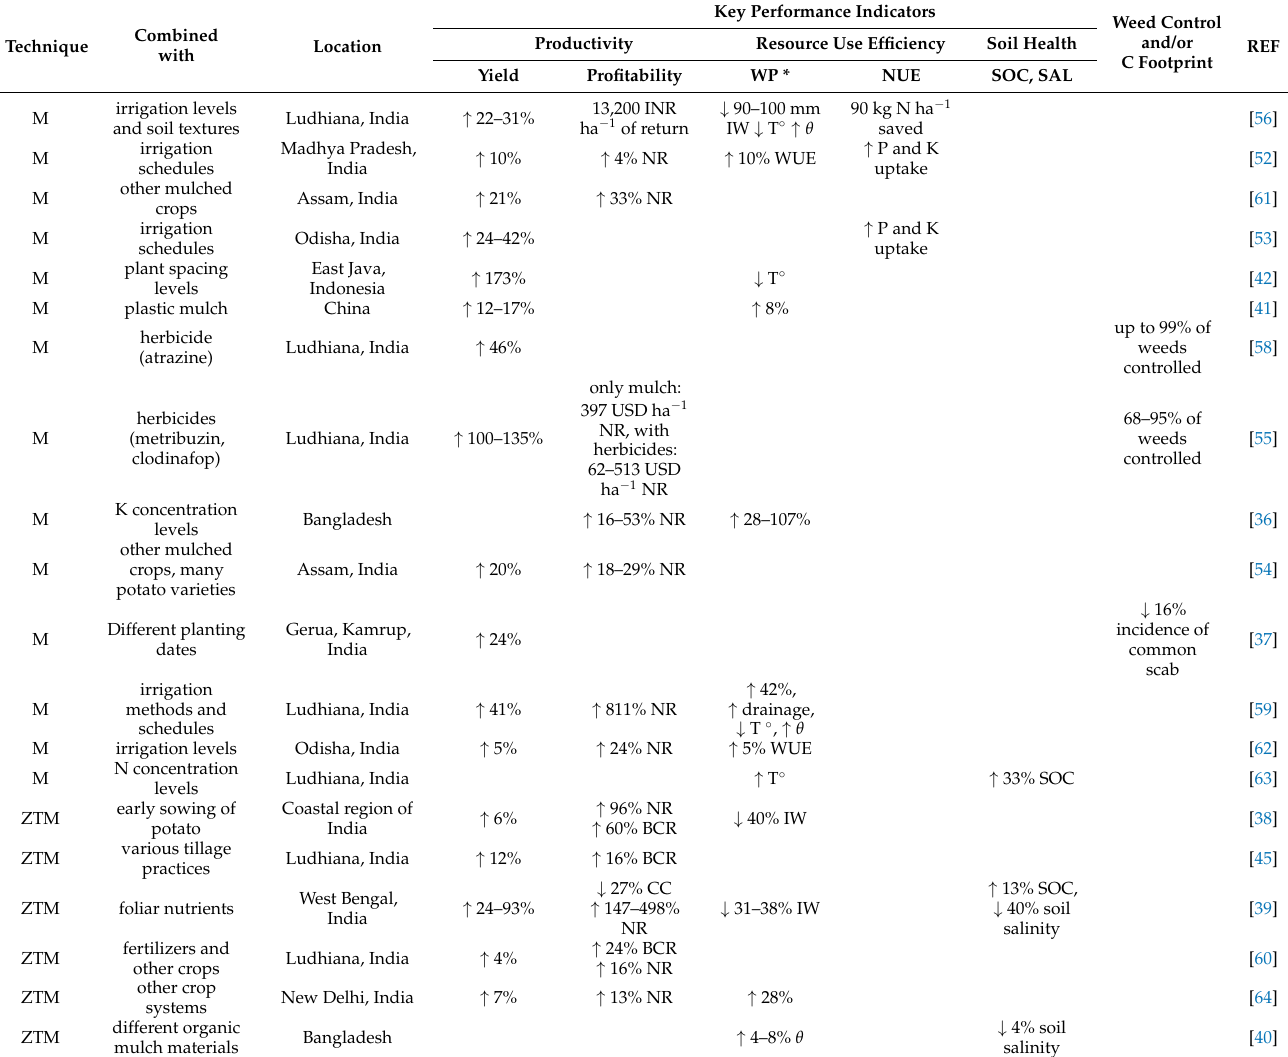
Table 2. Summary of the evidence of zero-tillage and/or organic mulch effects in potatoes on Saito et al. [22]’s key performance indicators and C footprint and weed control. The percentages of increase ( ↑ ) or decrease ( ↓ ) referred to the values obtained under control condition (i.e., under conventional practices without mulching and/or reducing/zero-tillage). REF = Reference. REFProductivity Resource Use